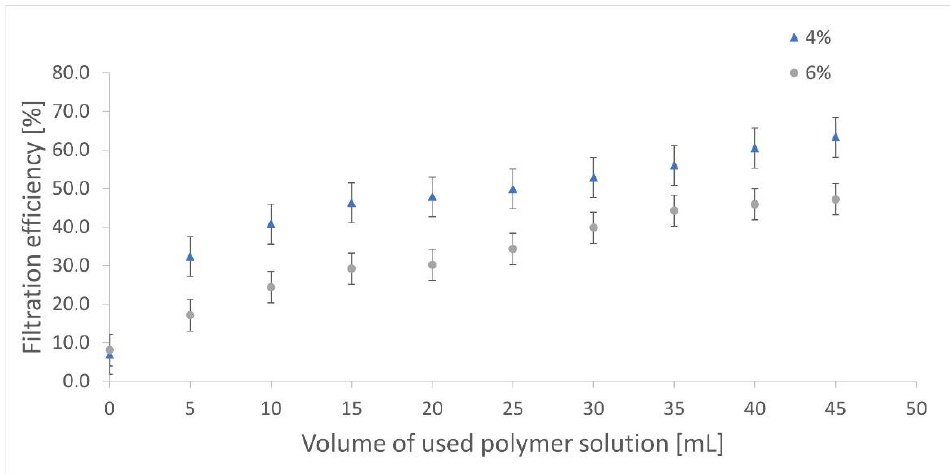
Figure 11. Dependence of the overall filtration efficiency on the volume of 4% and 6% PLA solution used for the fibers production.